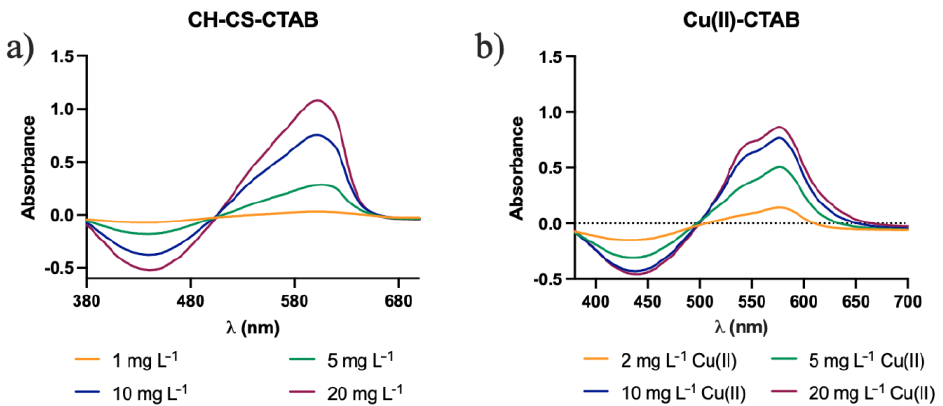
Figure 11. Graphical representation of the absorption spectra of CH-CS membranes after immersion in samples containing CTAB and: ( a ) Al(III); ( b ) Cu(II).